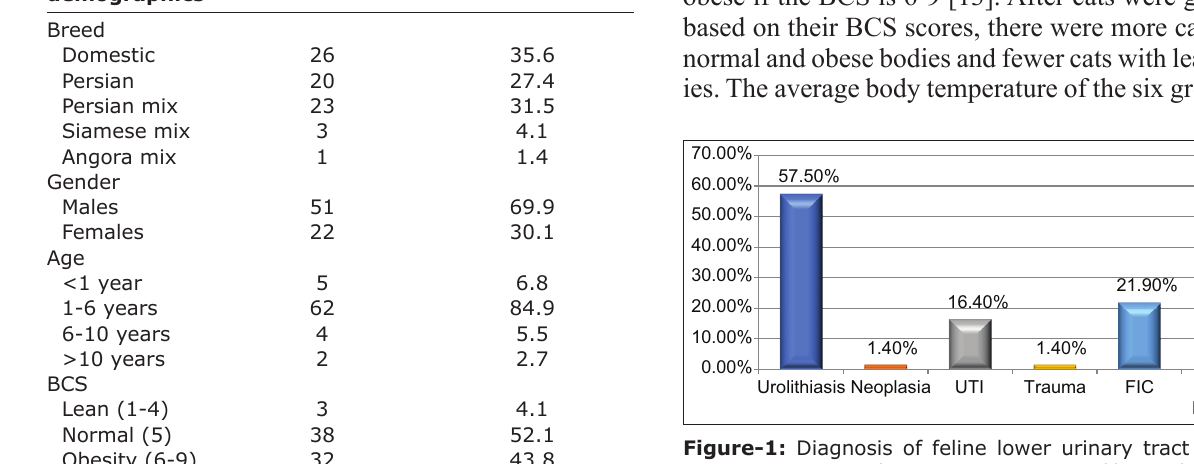
Table-1: Description of cat samples in animal clinics in Sleman Regency. Variable Frequency (tails) Percentage (%) demographics